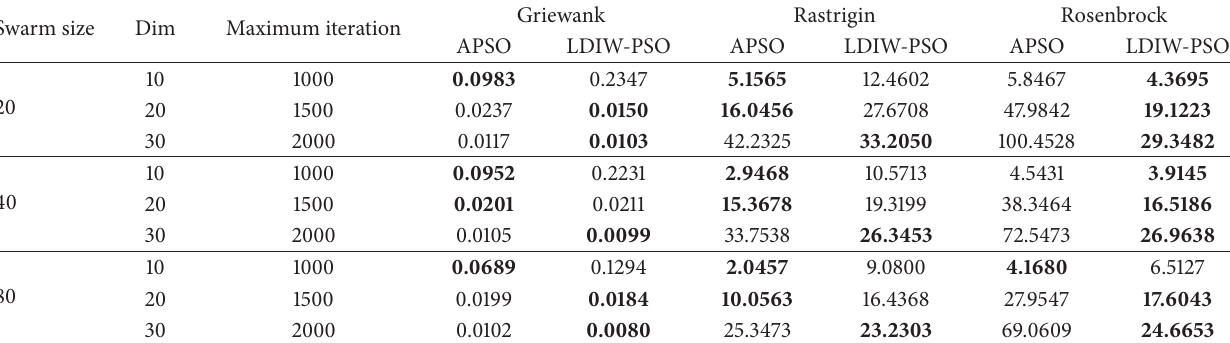
Table 7: Experimental results for LDIW-PSO compared with APSO.